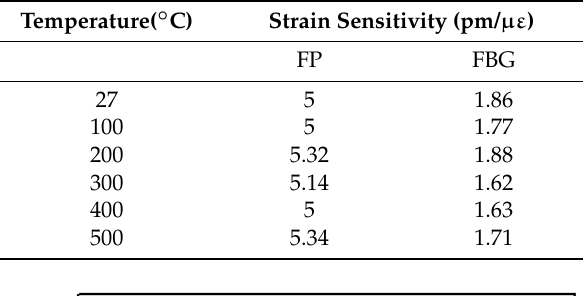
Figure 5. Strain responses of the sensor at different temperatures. ( a ) At 27 °C; ( b ) at 500 °C. Table 1. Strain sensitivities of the sensor at different temperatures.